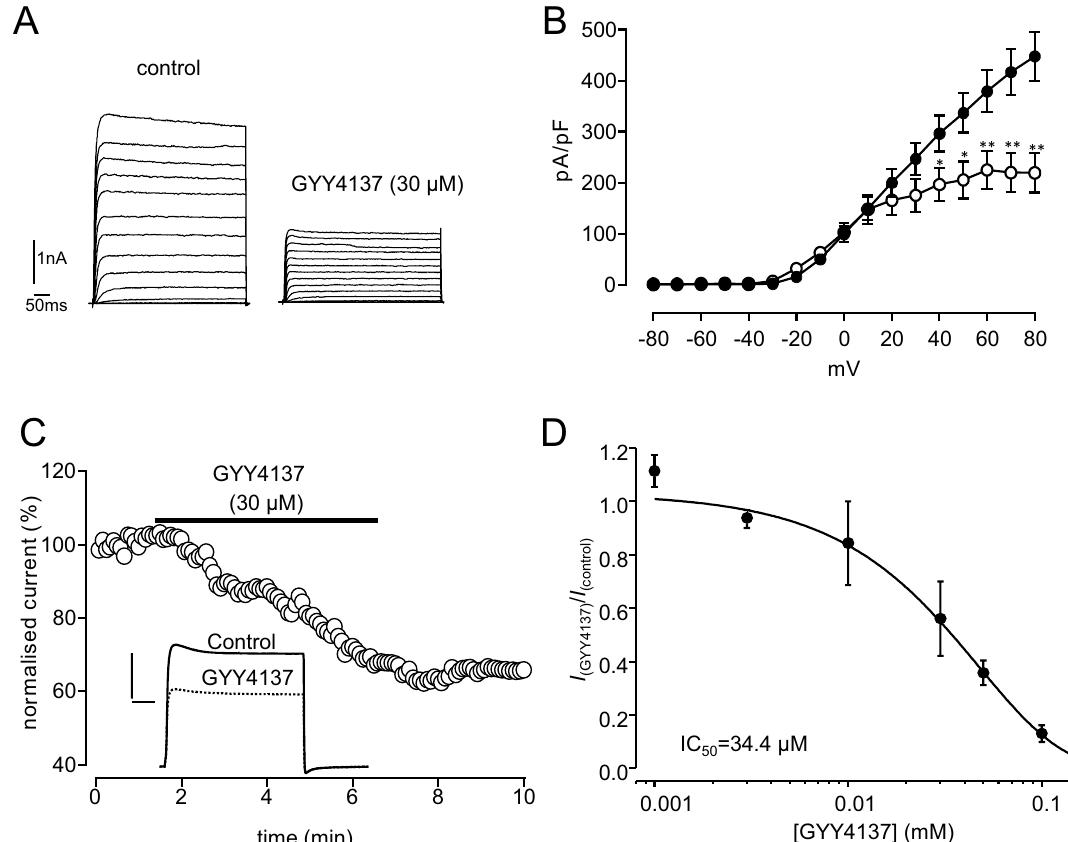
Figure 2. GYY4137 inhibits recombinant Kv2.1. ( A ) Families of currents evoked in a HEK293 cell stably expressing Kv2.1 before and during exposure to GYY4137 (30 μM). Currents were evoked by step- depolarizations, applied up to + 80 mV in 10 mV increments from a holding potential of -70 mV. Scale bars apply to both families of currents. ( B ) Mean (± s.e.m.) current–density versus voltage relationships obtained in 11 cells before (solid circles) and during (open circles) exposure to GYY4137 (30 μM). Significance: * P < 0.05; ** P < 0.01 as compared with controls. ( C ) Example time-series plot illustrating normalized current amplitudes evoked by step-depolarizations in a Kv2.1-expressing HEK293 cell. For the period indicated by the horizontal bar, GYY4137 (30 µM) was applied via the perfusate, indicated by horizontal bar, followed by washout. Inset shows example currents under the different experimental conditions scale bars: 2 nA (vertical) and 10 ms (horizontal). ( D ) Mean (± s.e.m., each point taken from 3 to 5 cells) concentration–response relationship fitted to sigmoidal Boltzmann function illustrating the effects of GYY4137 on Kv2.1. Inhibition was determined using currents evoked by step-depolarizations from − 70 to + 50